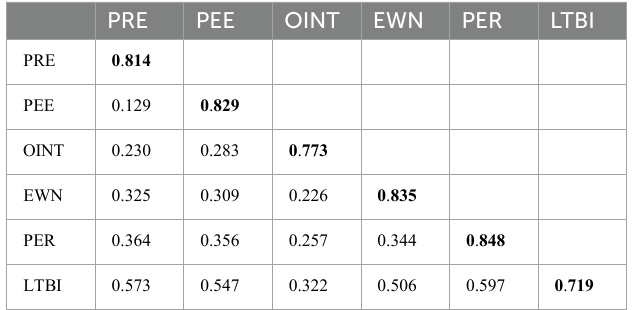
TABLE 3 Discriminant validity